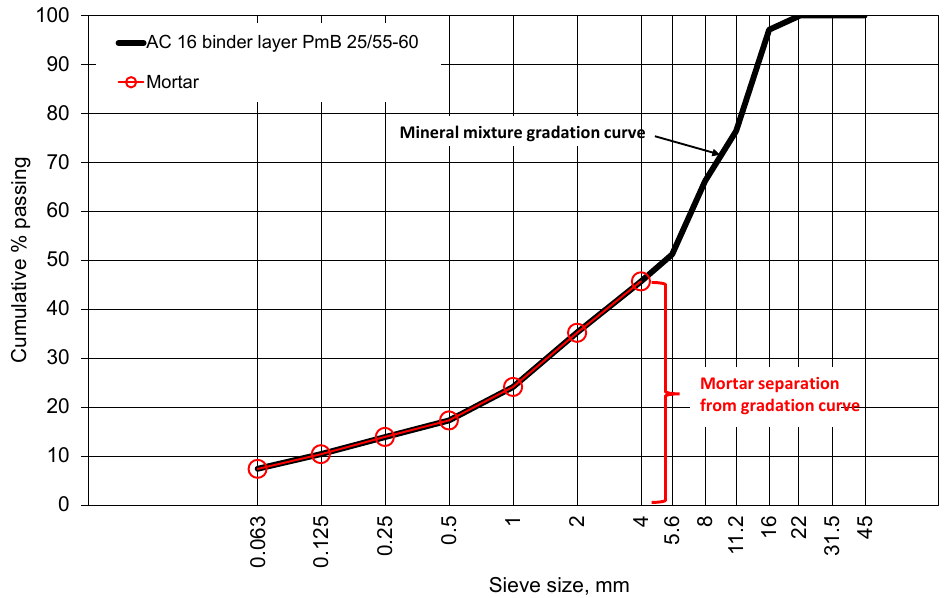
Figure 1. Asphalt concrete and mortar asphalt gradation curve.